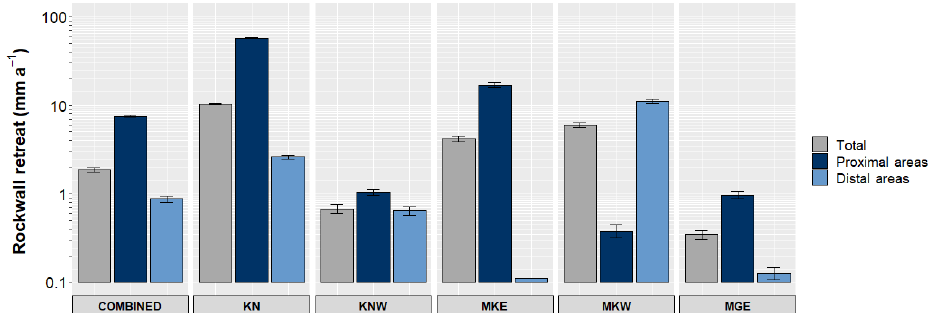
Figure 5. Rockwall retreat rates (mma − 1 ) for the entire rockwall (grey), for proximal areas (0–10m, dark blue) and for distal areas ( > 10m, light blue). The mean rate over the 6-year observation period is just under 2mma − 1 . Rockwall retreat rates in proximal areas (7.6mma − 1 ) were almost an order of magnitude higher than in distal areas (0.9mma − 1 ).